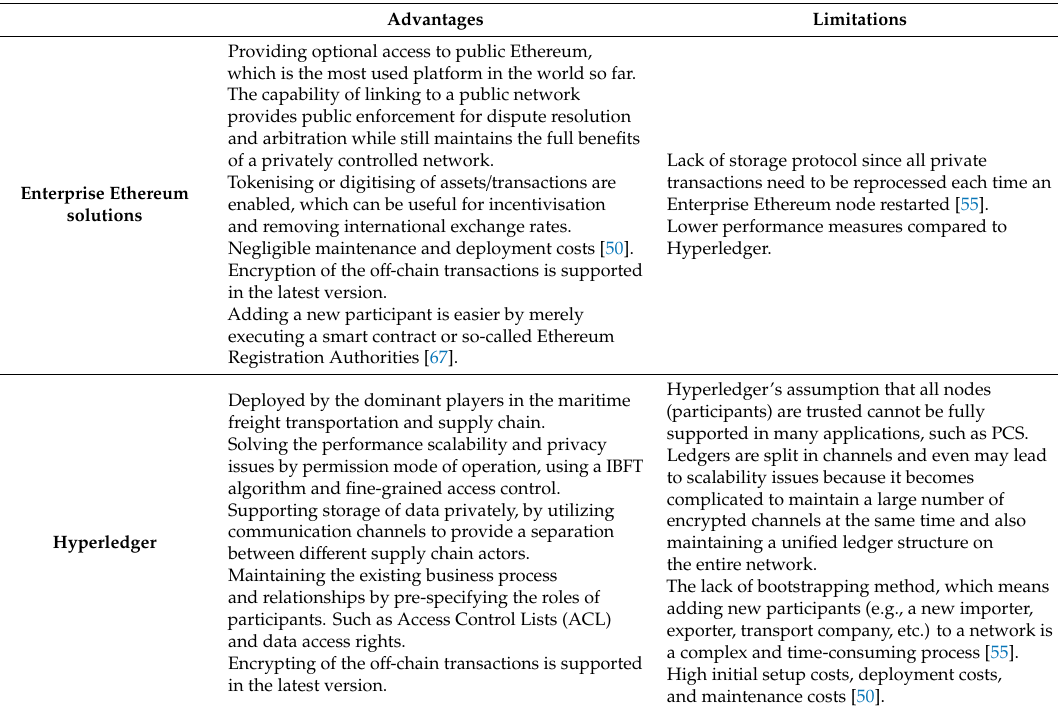
Table 3. Comparative analysis of the two most common blockchain platforms (developed by